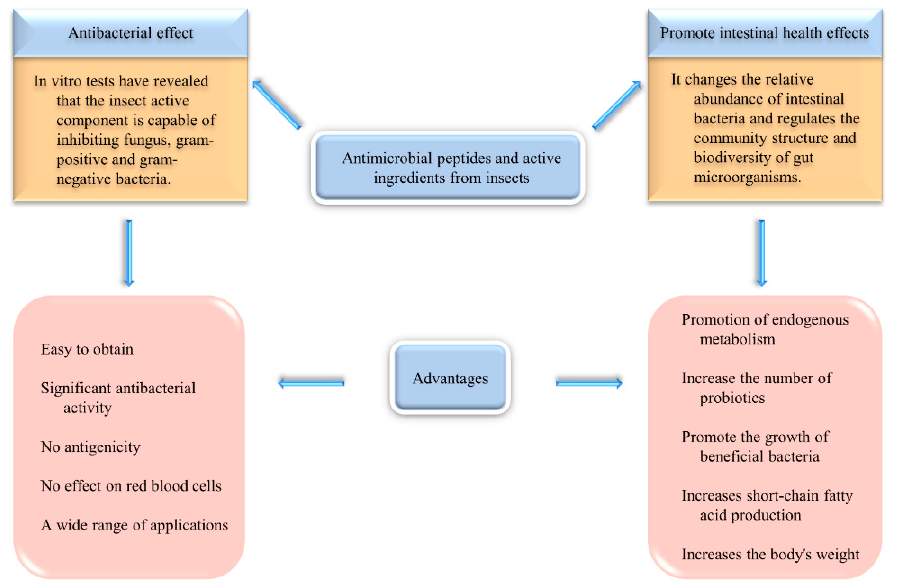
Figure 6. The antimicrobial activity of insect active substances and their effects on intestinal bacteria, as well as the advantages of action effect.